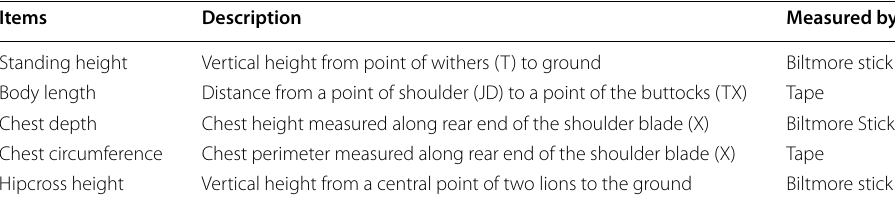
Table 1 Common morphological parameters of yaks Items